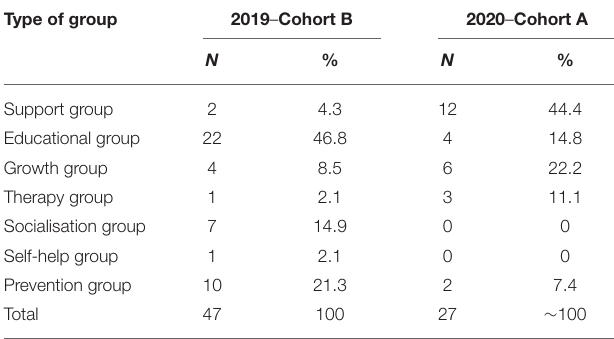
TABLE 7 | Type of group by purpose − 2019 and 2020